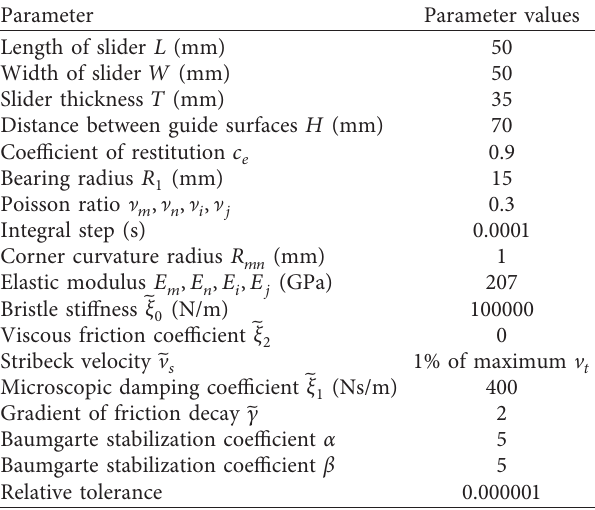
Table 3: Clearance joints’